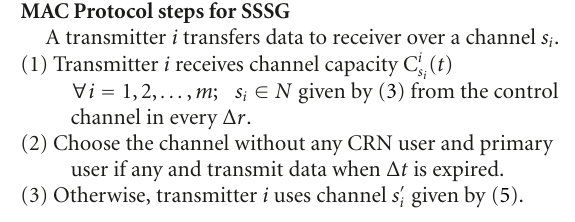
Algorithm 2: The MAC scheduler for cooperative